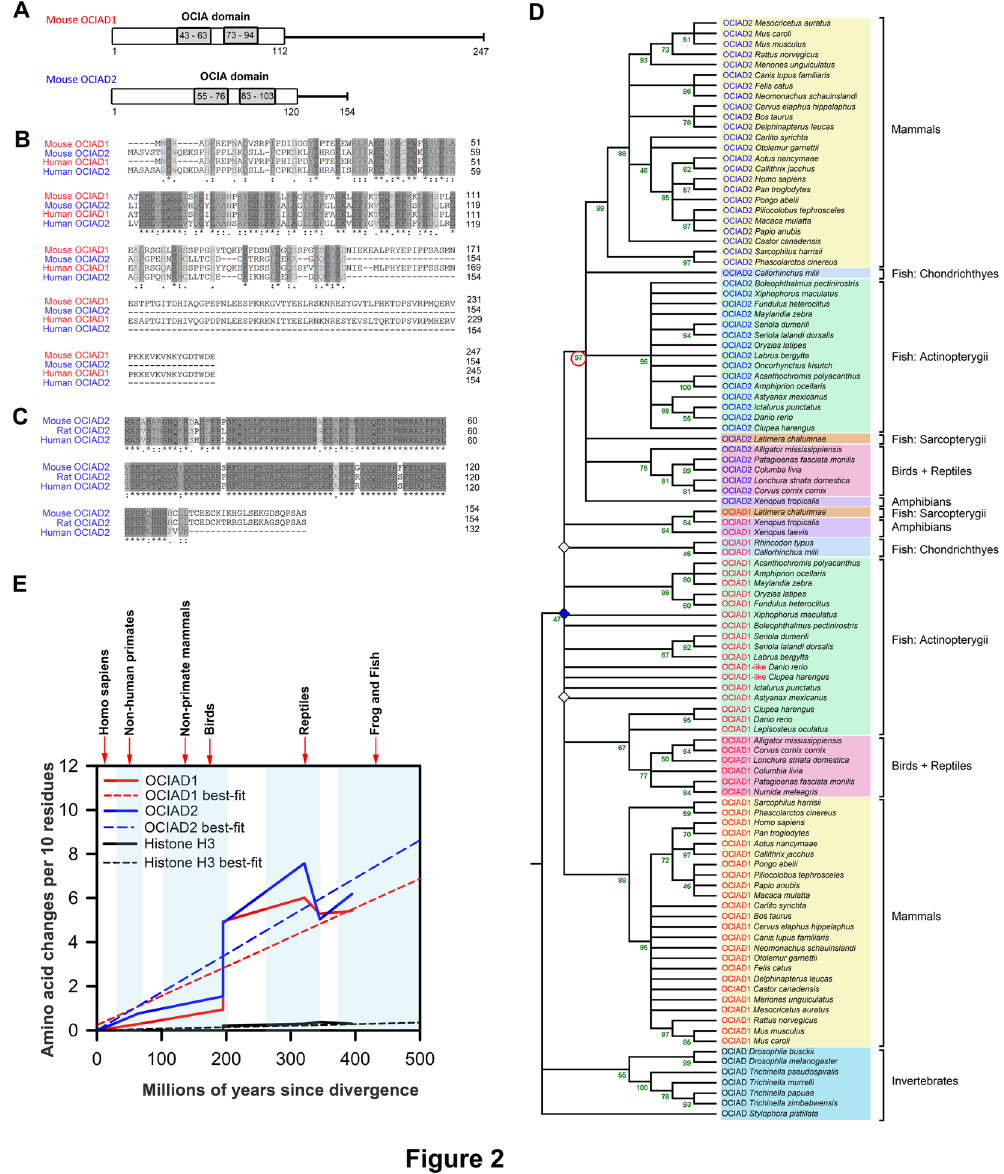
Figure 2. Phylogenetic analysis of the OCIAD proteins. ( A ) Schematic representation of the mouse OCIAD1/ Asrij and OCIAD2 protein organization. ( B ) Multiple sequence alignment of OCIAD1/Asrij and OCIAD2 protein sequences (using MUSCLE) from mouse and human showing conserved regions. Dark shading shows amino acids identical in all sequences and light shading indicates similar amino acids. Numbers at the end of each sequence indicate amino acid positions. ( C ) Multiple sequence alignment of the predicted mouse, rat and human OCIAD2 open reading frames (using MUSCLE). ( D ) Evolutionary history of the OCIA domain proteins. The evolutionary history was inferred using the Maximum Likelihood method (see Methods). The tree with the highest log likelihood is shown. The percentage of replicate trees in which the associated taxa clustered together in the bootstrap test (100 replicates) are shown next to the branches, in green. The tree is a topology only tree and nodes with a bootstrap value less than 45 have been collapsed and shown as polytomies. Our analysis involved 106 amino acid sequences from 58 unique species. All positions containing gaps and missing data were eliminated, leaving 93 positions in the final dataset. Gene duplications are inferred using the method described in 23 . Three gene duplication events (diamonds) were identified in the tree. Open diamonds mark duplication nodes with low bootstrap values and blue diamond marks duplication node with highest bootstrap value (47). Given that there is only one copy of OCIA-domain containing proteins in invertebrates, these have been referred to as OCIAD. The extra copy of OCIAD1 protein present in Danio rerio and Clupea harengus has been listed as OCIAD1-like protein in the tree. ( E ) Sequence conservation analysis of vertebrate OCIAD1 (red line) and OCIAD2 (blue line) with respect to a conserved protein Histone H3 (black line) across different taxa. The dotted lines represent best-fit whereas solid lines represent the original